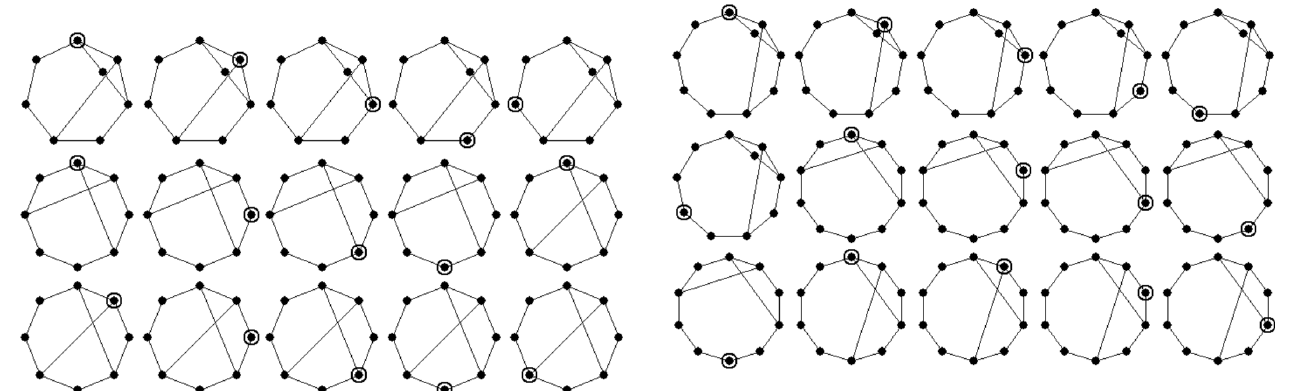
Figure 9. A part of the 10-link 3-DOF kinematic chain